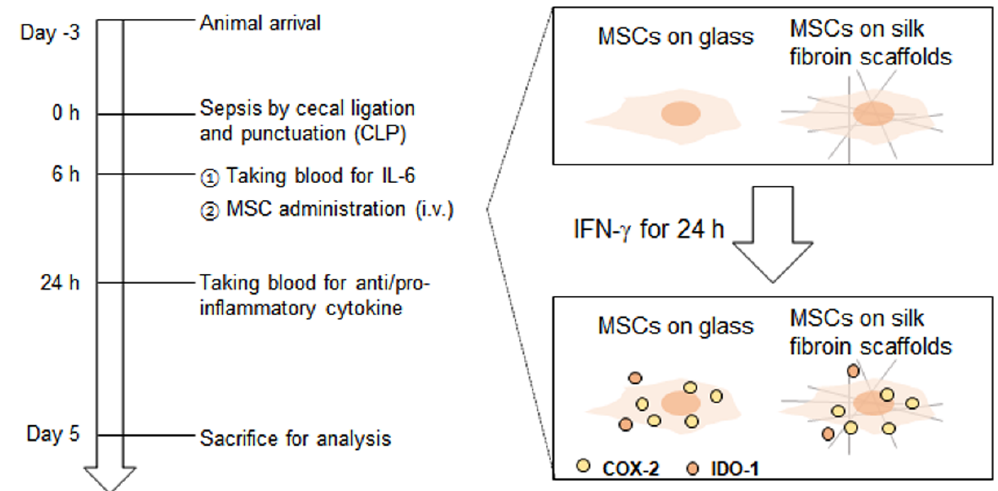
Figure 2. Representation of the experimental scheme. MSCs were pre-incubated with 100 ng/mL human IFN- γ for 24 h before administra- tion. The cecum of the C57BL/6 mice was ligated and punctuated with a 21G needle for polymicrobial sepsis. Six hours after the CLP, the mouse blood was collected from their tails in order to assess IL-6 levels. Primed MSCs on either the SF nanofibers or the control surfaces were intravenously administered to the septic mice with 10 6 cells. At 24 h after CLP, the plasma IL-6 levels were estimated. All groups were monitored for 5 days and sacrificed for biochemical analysis.